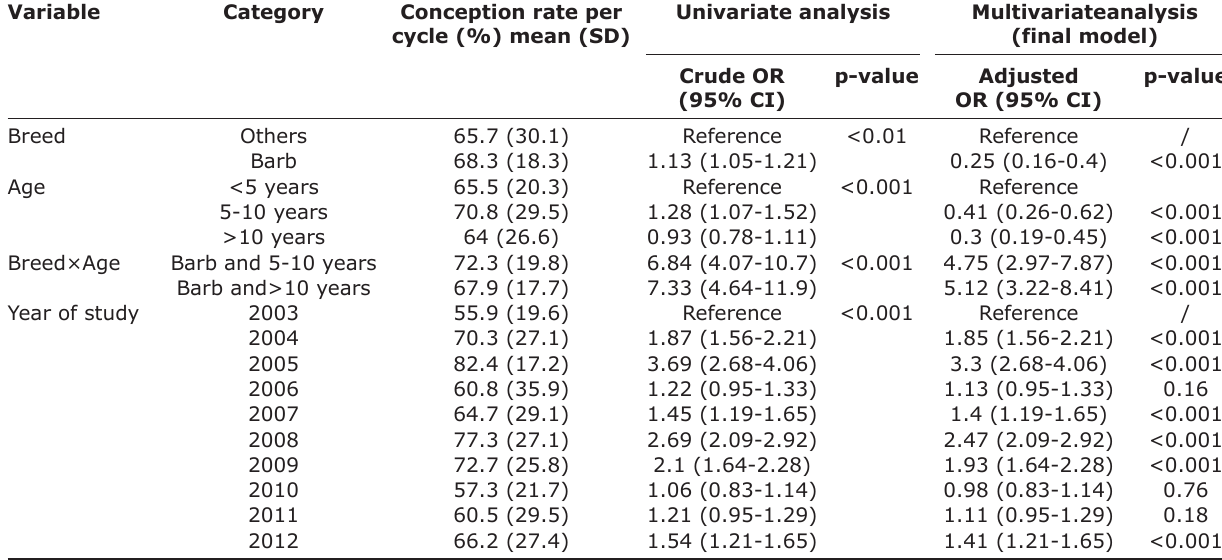
Table-4: Influence of breed, age of stallion, and year of study on conception rate per cycle.